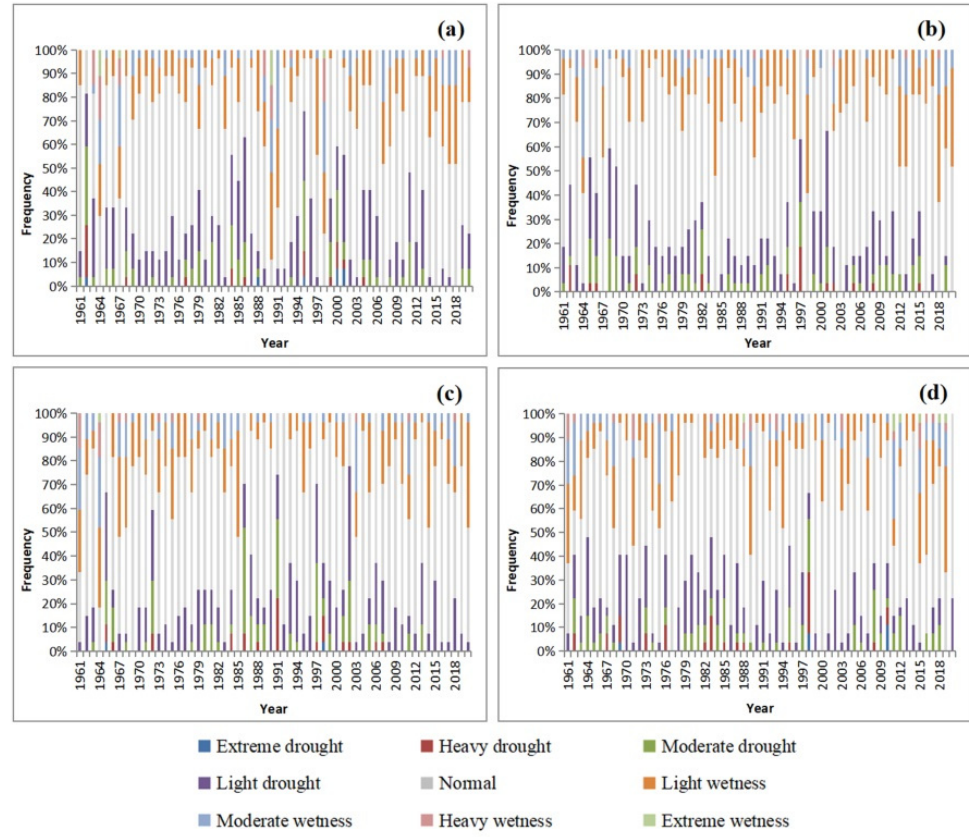
Figure 2. Frequency of different degrees of drought and wet events in spring ( a ), summer ( b ), autumn ( c ), and winter ( d ) in nine provinces of the Yellow River basin from 1961 to 2020.